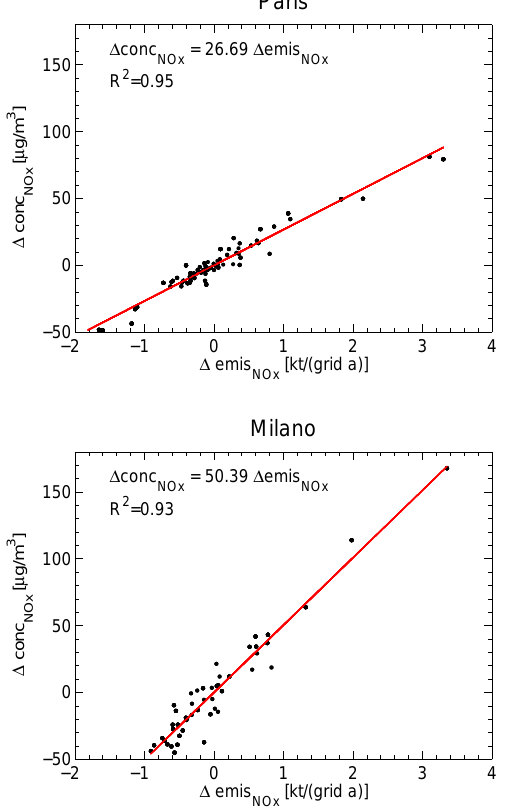
Fig. 3. NO x emission vs. concentration increments in the CHIMERE model run around two major European cities: Paris (top panel) and Milan (bottom panel). Each dot represents a grid cell. All EMEP grid cells which contain parts of the urban area are combined here. The linear fit is shown as a red line. Note the different slopes of the fit, corresponding to the different meteorological characteristics of these cities.